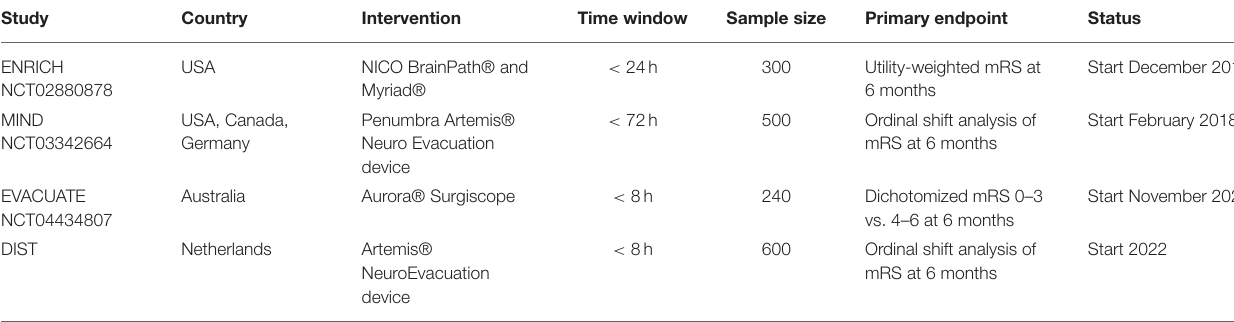
TABLE 5 | An overview of ongoing or scheduled randomized trials using minimally invasive surgery in intracerebral hemorrhage.